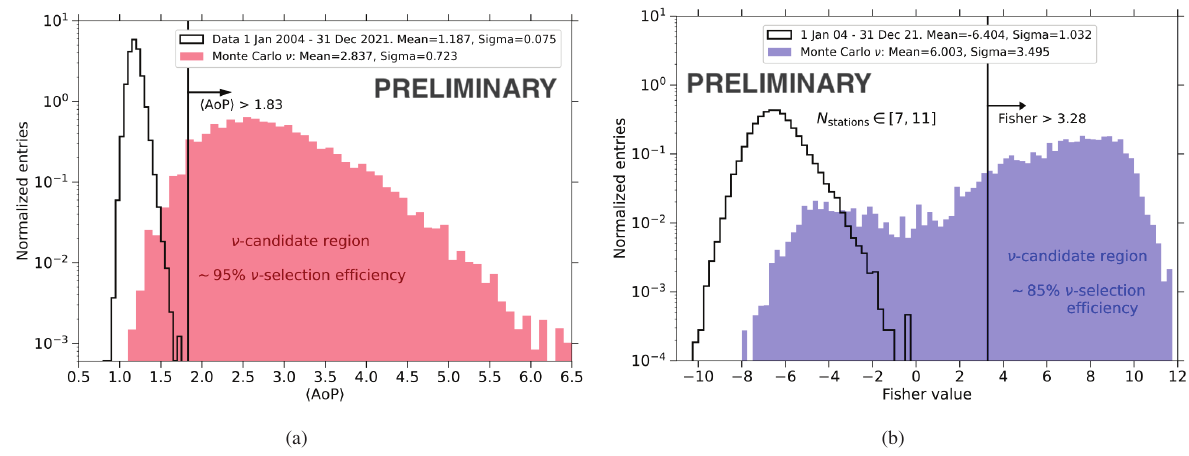
Figure 4. Results of the data unblinding shown exemplarily for two search channels; (a) ES channel, using the average area-over-peak in an SD event as discriminating observable; (b) DGH channel, in the sub-channel with N stations ∈ [7 , 11], where a Fisher discriminant analysis involving several observables constructed from the individual values of area-over-peak in an SD event.